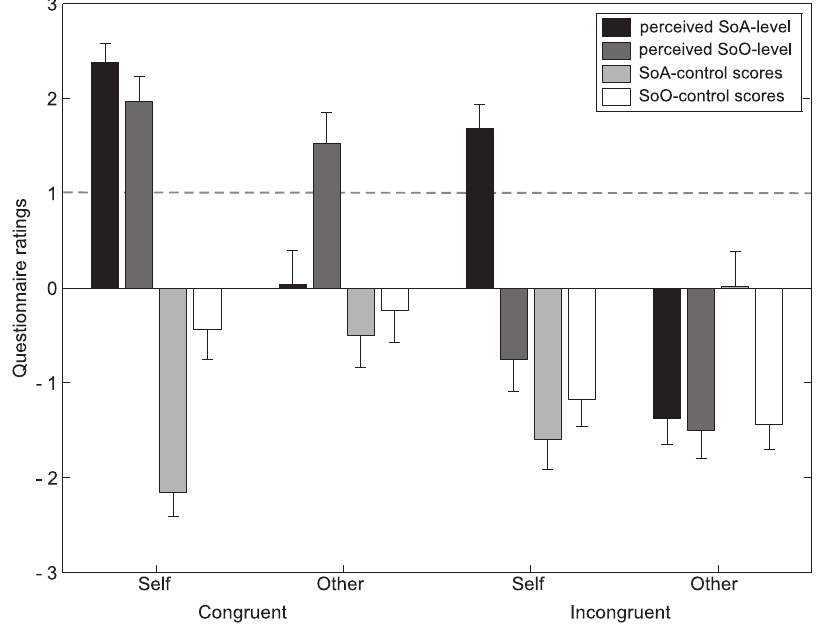
Figure 2. Explicit assessment of the SoA and SoO. Mean ( + SEM) questionnaire ratings for different experimental conditions are shown. Values above a criterion of 1, illustrated by a dashed line, reflect report of the illusion (cf. REF). Congruent/incongruent refers to positioning of the artificial hand relative to the participants hand, self/other refer to the mode of agency. SoA=sense of agency; SoO=sense of ownership.